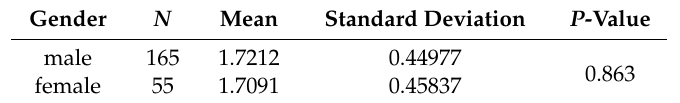
Table 2. Difference between mean and standard deviation of gender of studied personnel.